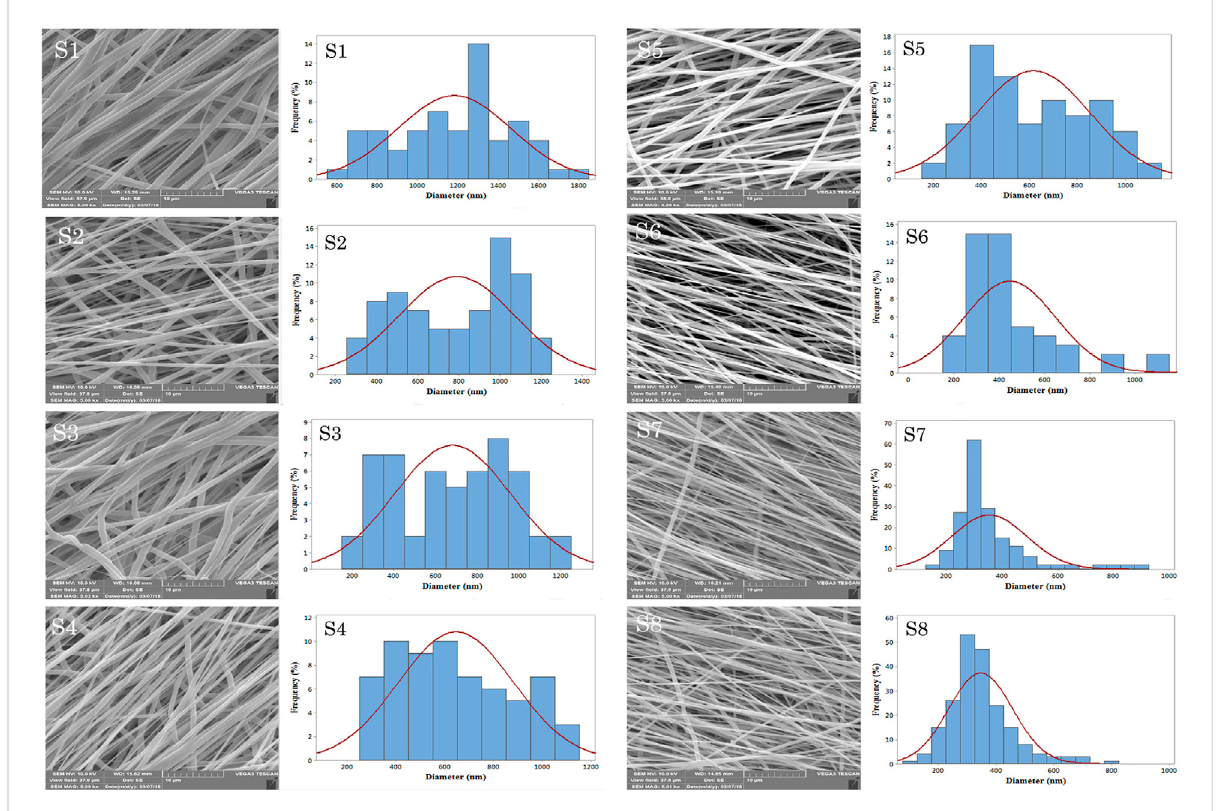
FIGURE 8 The SEM micrographs of electrospun scaffolds with the magni fi cation of 5.00 Kx: S1, S2, S3, S4, S5, S6, S7, and